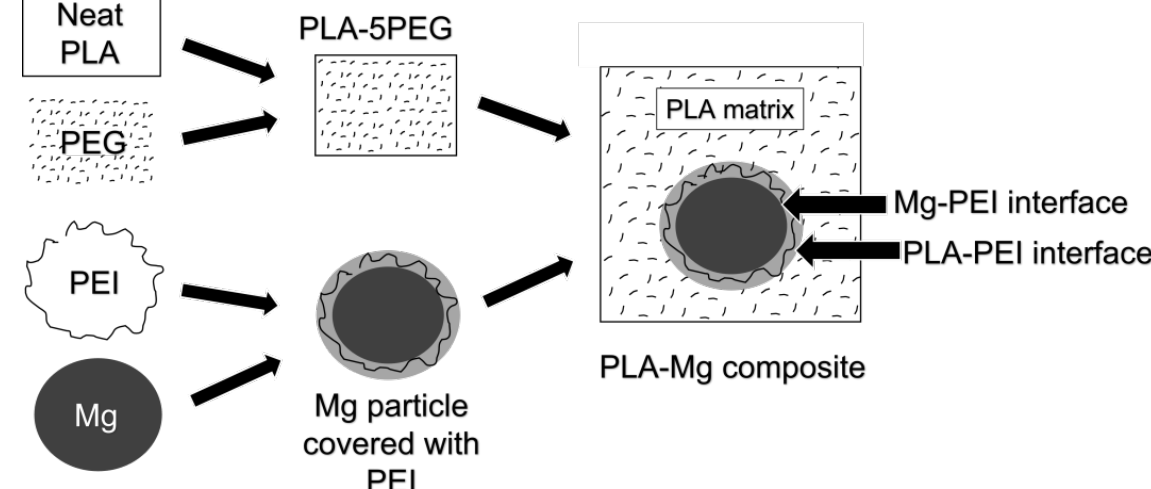
Figure 1. Scheme of the PLA-Mg material produced. The PLA and PLA-Mg filaments were thermally extruded via FFF at 190 ◦ C and 155 ◦ C, respectively, to form 1D filaments, in ambient humidity and at room temperature (23 ± 1 ◦ C). Filaments 300 to 400 microns in diameter were obtained. A PRUSA i3 MK3S with a 0.4 mm nozzle was used. Adding 5 wt.% of PEG made the printability of PLA-Mg filaments possible at 155 ◦